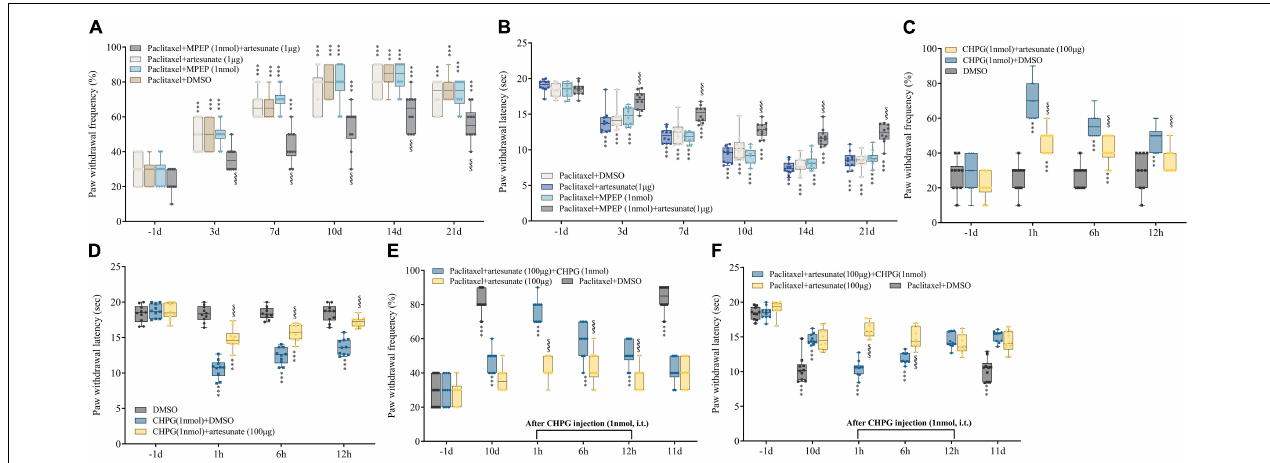
FIGURE 4 | Involvement of mGluR5 in artesunate antinociception in PINP in mice. (A,B) Artesunate (1 µ g) and the mGluR5 antagonist MPEP (1 nmol) were administered by intrathecal injection 10 min prior to paclitaxel treatment. Artesunate and MPEP jointly administered at subthreshold amounts starkly reduced paclitaxel-associated mechanical allodynia and thermal pain. (C,D) Artesunate (100 µ g) administration was performed by injection 10 min prior to treatment with the mGluR5 agonist CHPG (1 nmol). Artesunate treatment starkly reduced CHPG-associated mechanical allodynia and thermal hyperalgesia. (E,F) CHPG injection (1 nmol) was administered to mice 10 days after the initial paclitaxel administration. The pain alleviating effect of artesunate on PINP was partially reversed by intrathecal injection of the mGluR5 agonist CHPG. Data are median with interquartile ranges, and individual data points are shown ( n = 10). *** P < 0.001 vs. Baseline ( − 1d); $$$ P < 0.001 vs. Paclitaxel + DMSO group/DHPG + DMSO group/Paclitaxel + artesunate + GHPG group at the same time